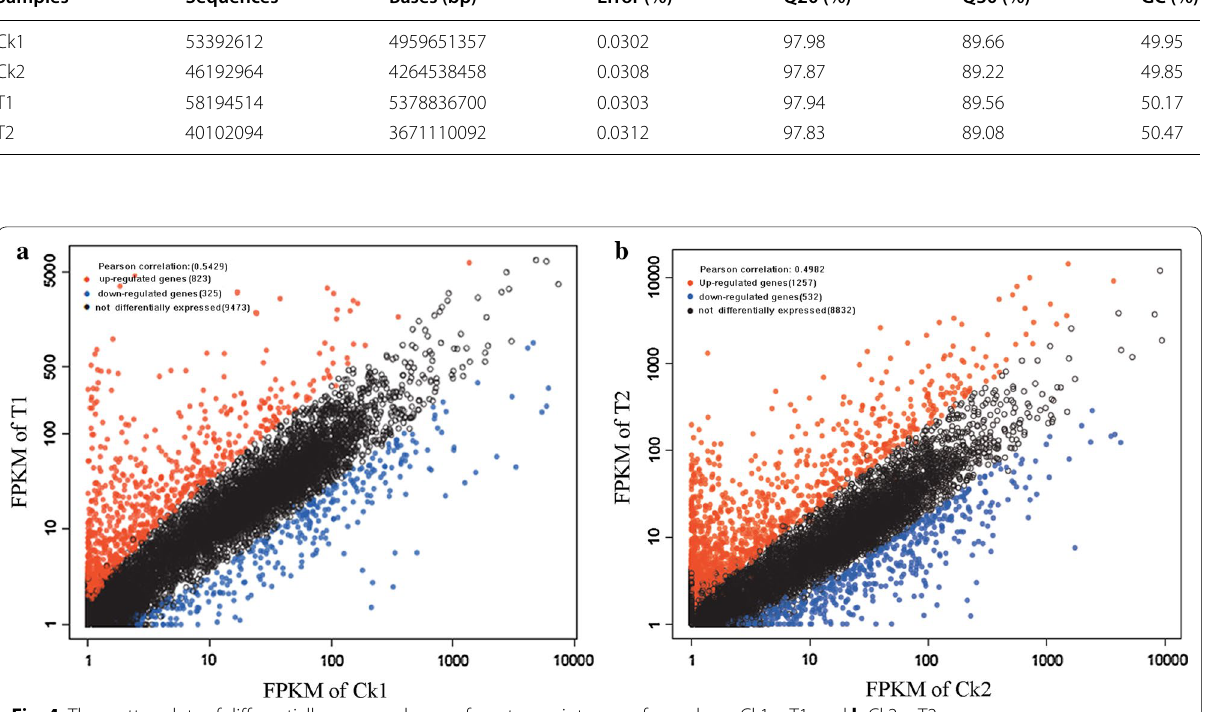
Fig. 4 The scatter-plots of differentially expressed genes from transcriptomes of samples. a Ck1vs T1, and b Ck2